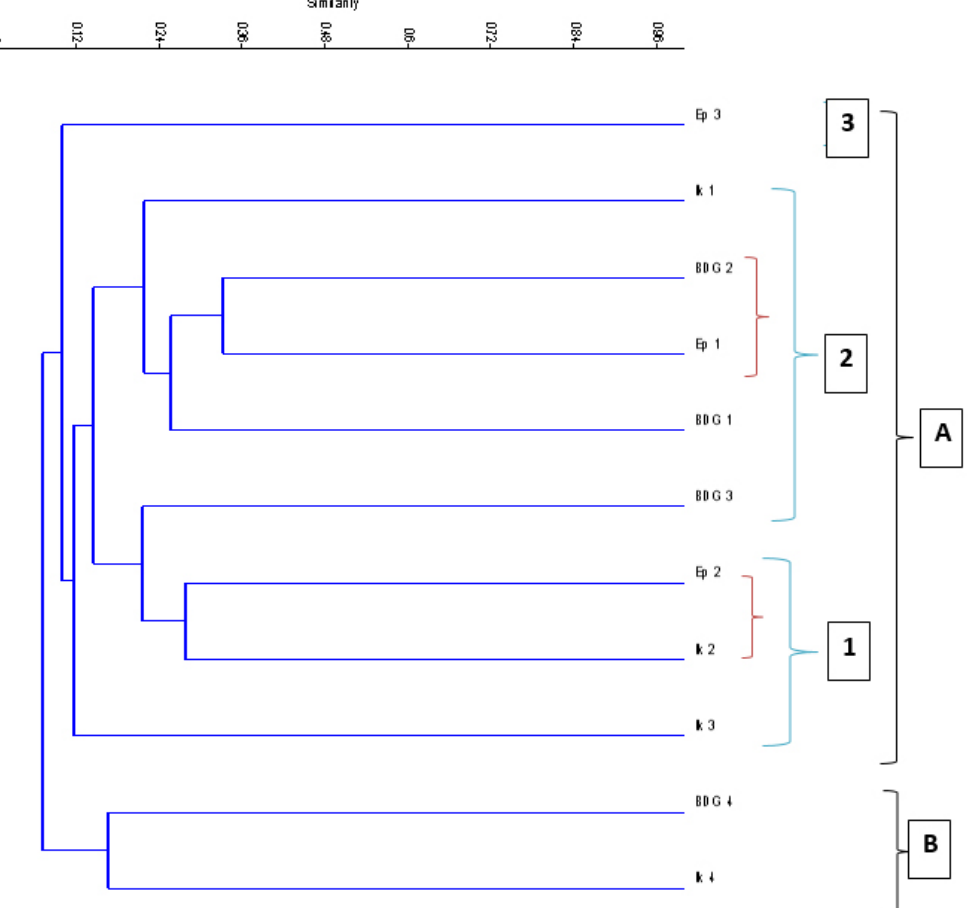
Figure 7. Jaccard Correlation (dendogram) showing the similarities among the sampled locations. A: Secondary forest ecosystem (Number in boxes indicates mosaic vegetations: 1, dry secondary forest ecosystem; 2, fresh water swamp forest; 3, dry and swamp forest); B: Mangrove ecosystem; BDG, Badagry (1-4), Ep, Epe (1-3), and IK–Ikorodu (1-4). Group B which included individuals